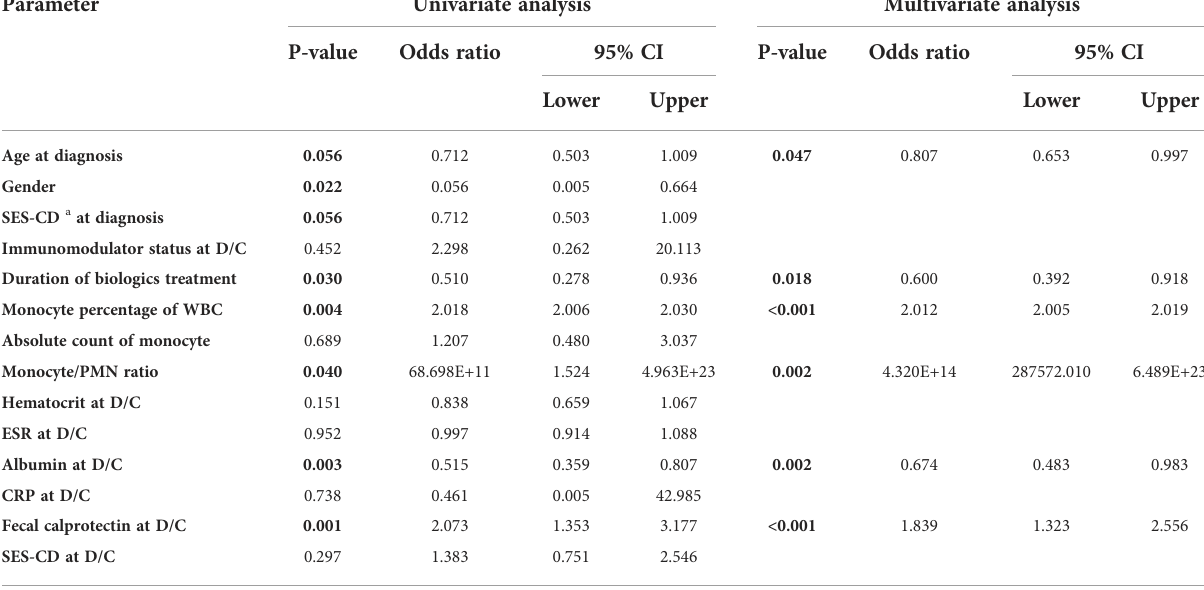
TABLE 4 Multivariate logistic regression analysis for evaluation of risk factors for relapse after discontinuation of biologics in pediatric patients with Crohn ’ s disease. Multivariate analysis was performed by selecting a variable with P < 0.1 in univariable analysis. Parameter Univariate